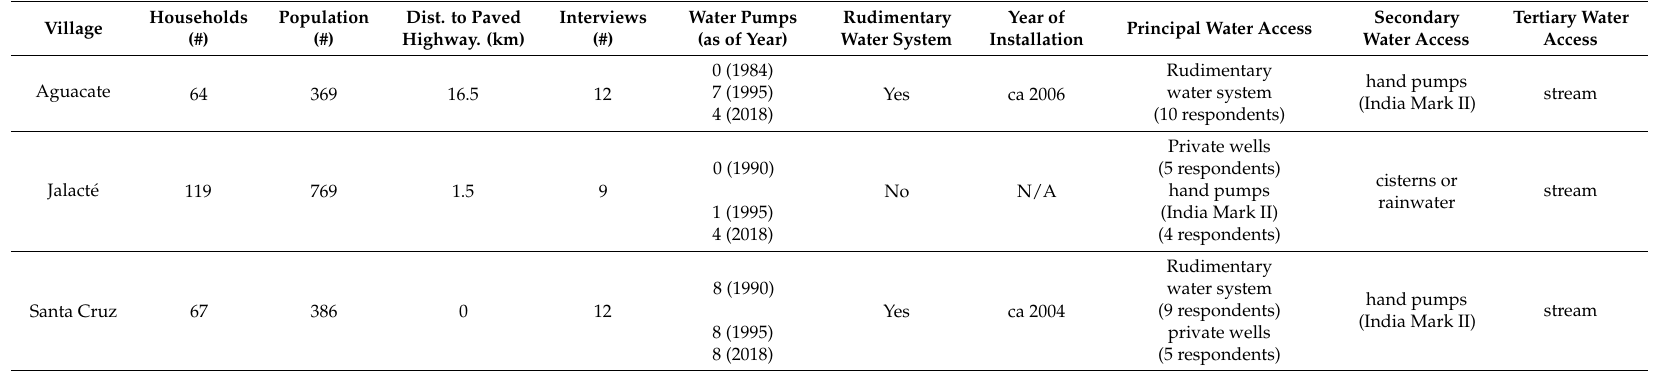
Table 1. Summary of population, water system, and other pertinent statistics for each of the three study communities. Household and population data were taken from the 2010 census [10]. Data on principle water access was drawn from interviews, with number of respondents